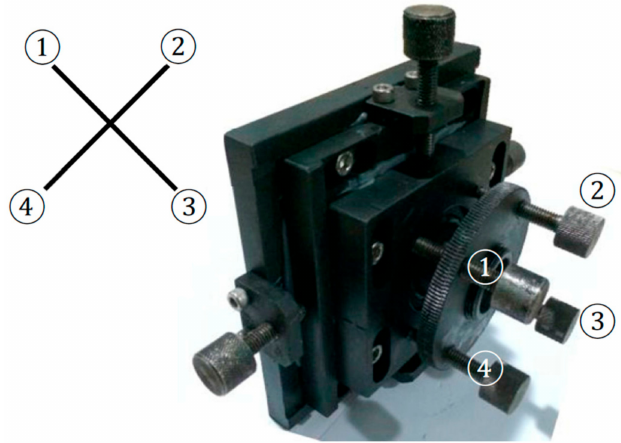
Figure 14. Physical picture of the novel apparatus for adjusting the cast and helix of wire